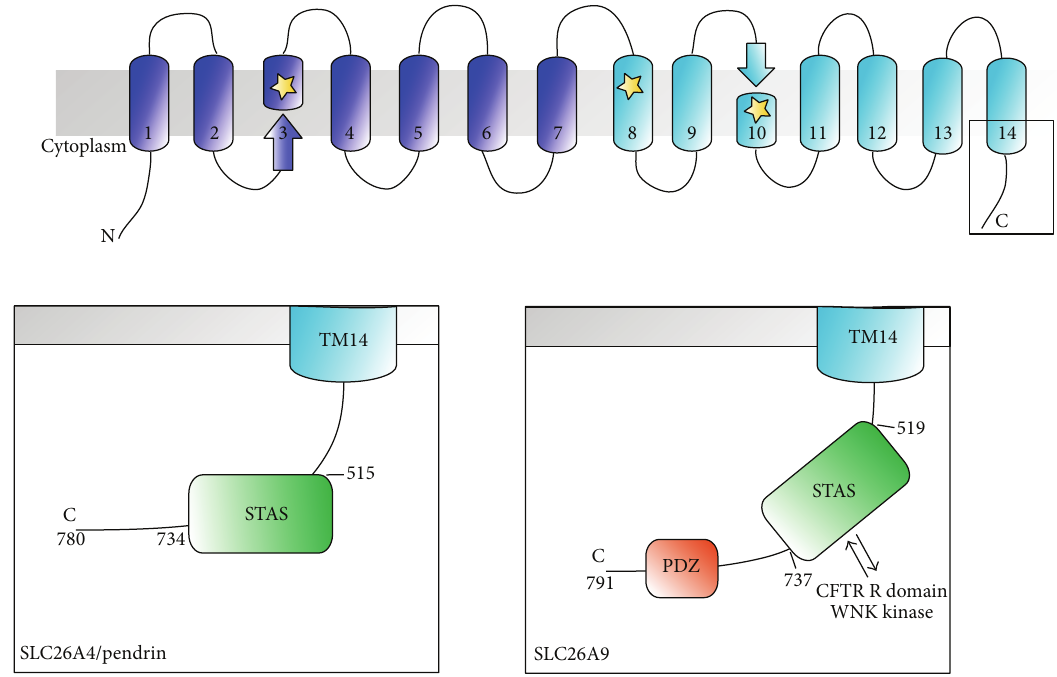
Figure 4: Domain architecture schematic for human SLC26 family proteins discussed here, SLC26A4 (pendrin) and SLC26A9, based on the crystal structure of SLC26Dg (PDB ID 5DA0). Upper inset shows general schematic while the lower insets show details of the C-terminal cytoplasmic region for each protein. Labels denote the following domains: STAS: sulfate transporter and antisigma factor antagonist domain; PDZ: PSD95-Dlg1-Zo-1 domain. Locations of SLC26A9 interaction with CFTR R domains and WNK kinases are denoted. The location of residues of a crystallographically determined ligand binding site is highlighted with